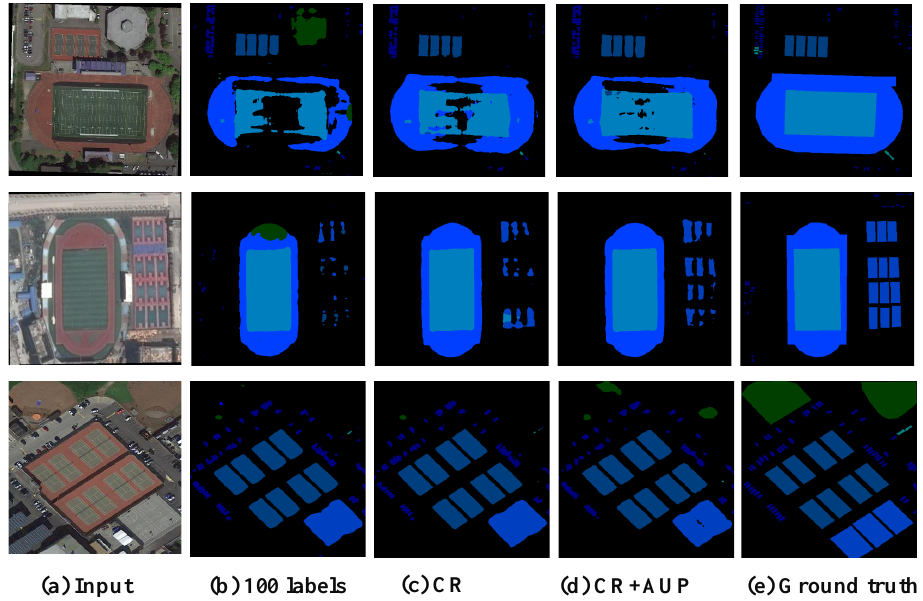
Figure 6. Some examples of remote sensing image semantic segmentation when the proposed CR and AUP are adopted on validation set of ISAID dataset.